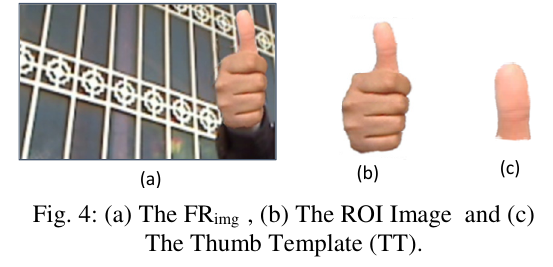
with the boundary pixels Fig. 2: The B (cid:6)(cid:7)(cid:8)